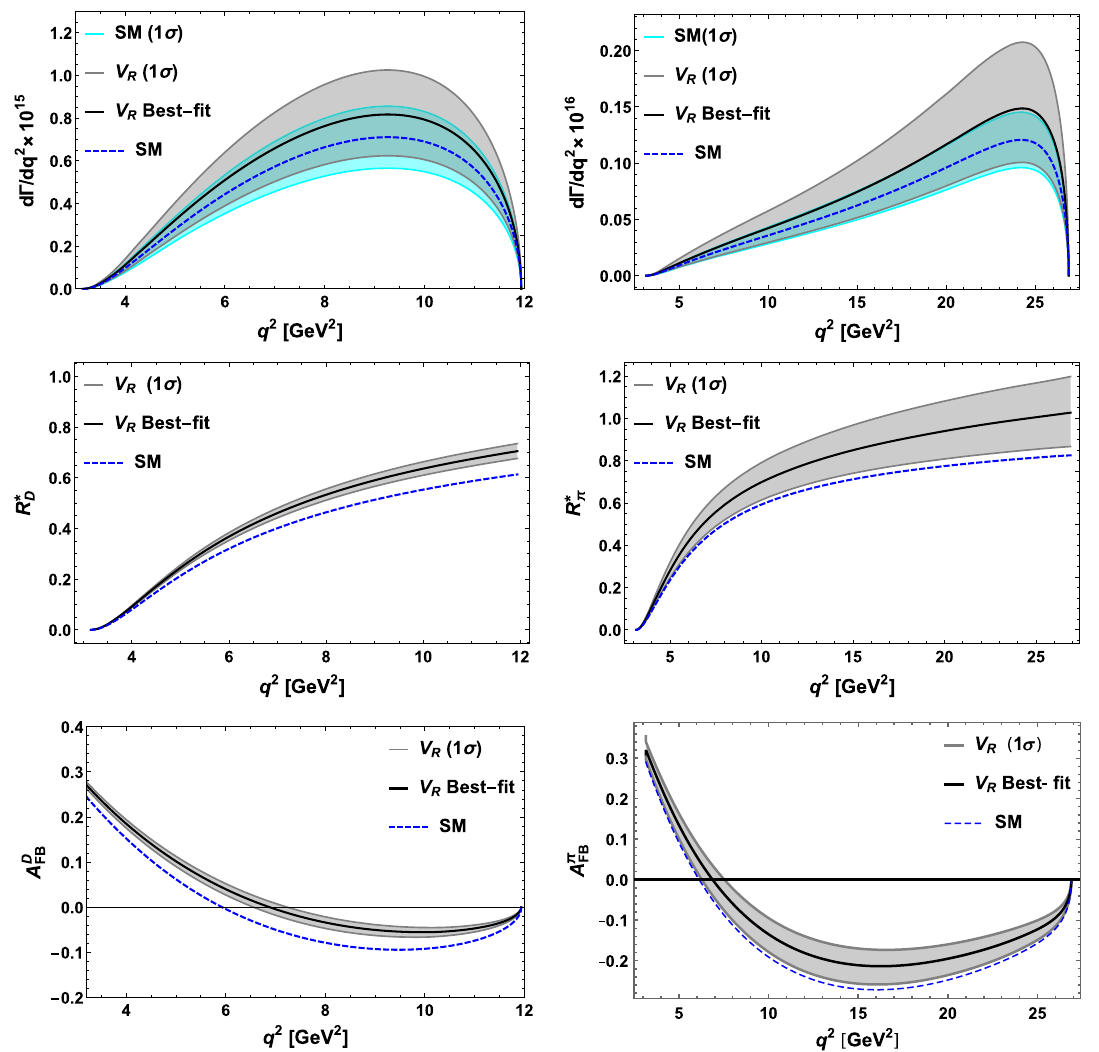
Fig. 4 The q 2 variation of differential decay rate, lepton nonuniver- saity parameter and forward–backward asymmetry of ¯ B ∗ → π + τ ¯ ν (right panel) in presence of new V (left panel) and ¯ B ∗ d